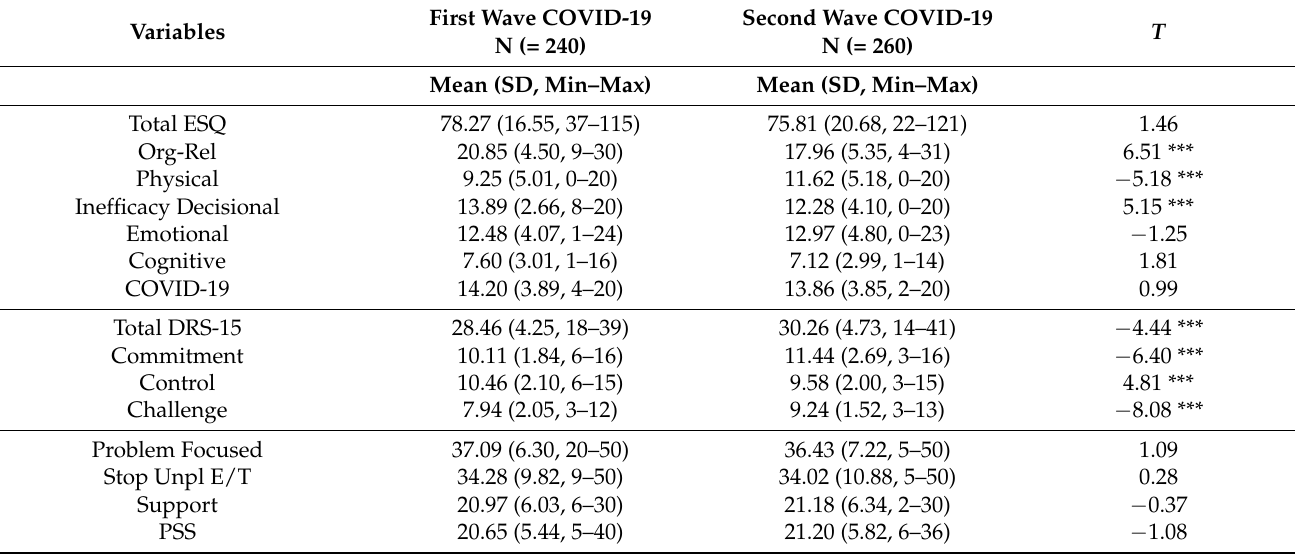
Table 2. t -test between two